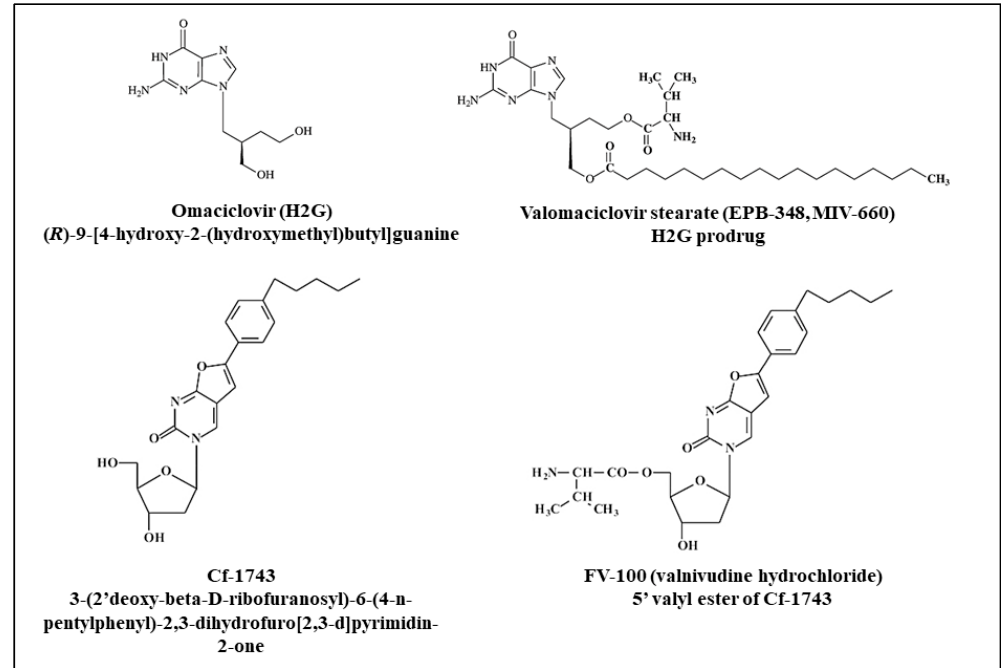
Figure 3. Anti ‐ VZV drugs in advanced development. Chemical structures of CF ‐ 1743 and its prodrug valnivudine hydro ‐ Figure 3. Anti-VZV drugs in advanced development. Chemical structures of CF-1743 and its prodrug valnivudine chloride (FV ‐ 100) and of omaciclovir (H2G) and its prodrug valomaciclovir stearate. hydrochloride (FV-100) and of omaciclovir (H2G) and its prodrug valomaciclovir